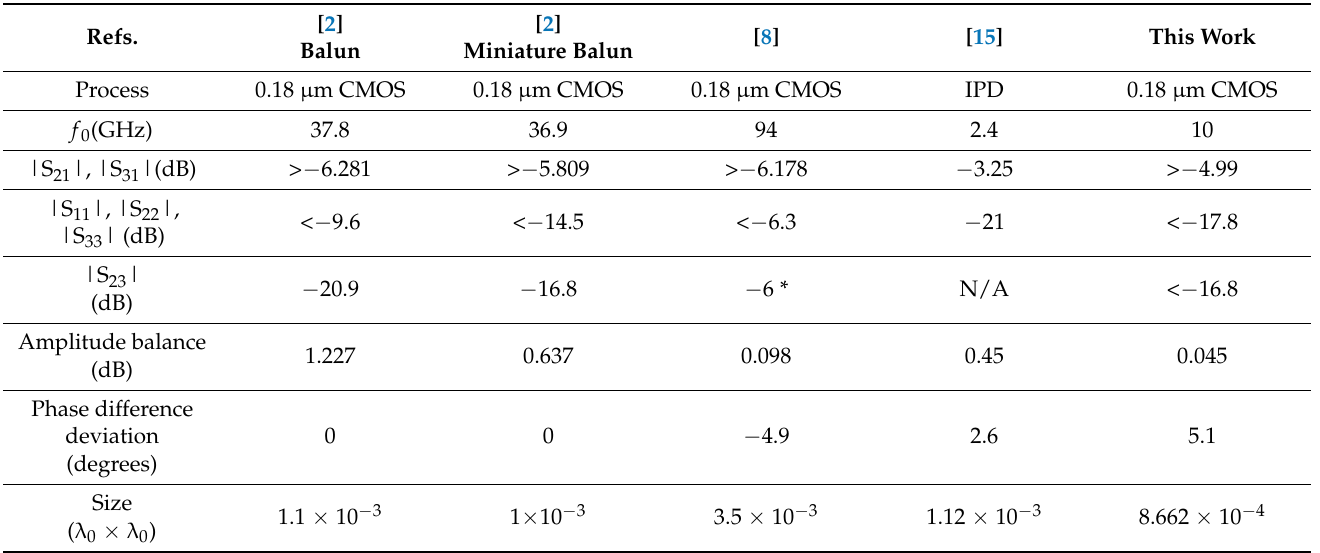
Table 4. Comparison of previously reported on-chip